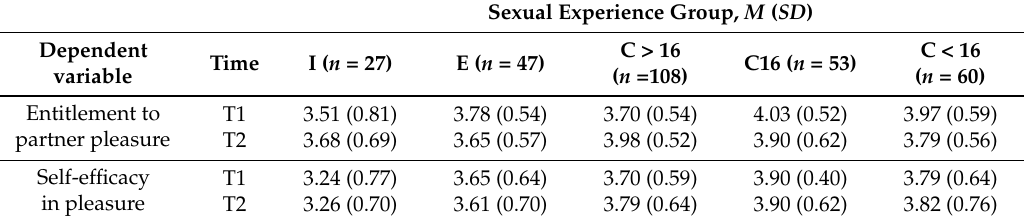
Table 5. Mean and SD of entitlement to sexual partner pleasure and self-efficacy in achieving pleasure by sexual behavior group ( N =